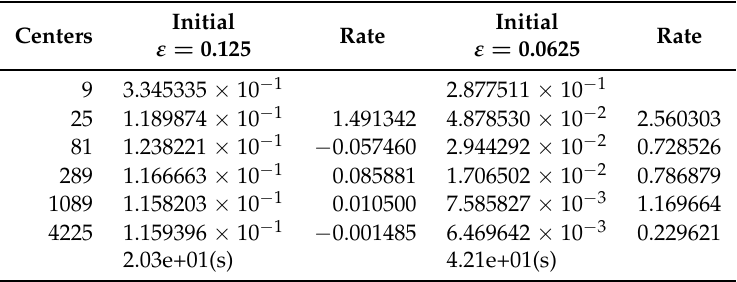
Table 8. Multilevel collocation: with initial 0.125 and 0.0625.